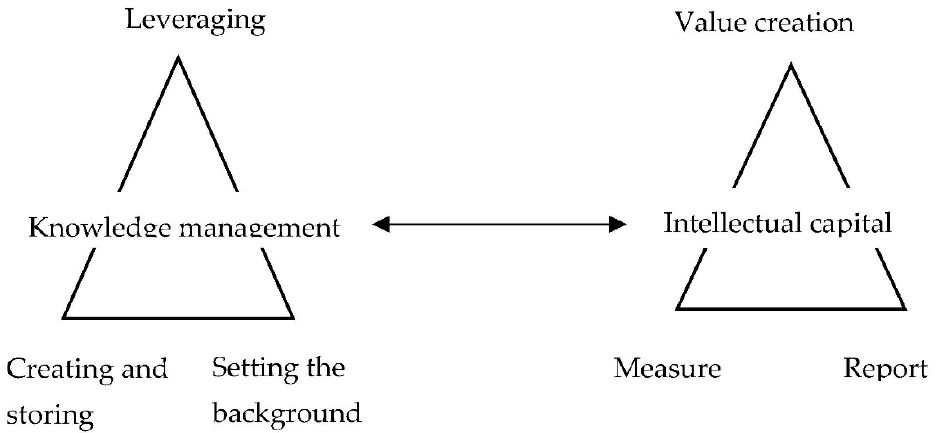
Figure 1. Nexus between intellectual capital and knowledge management.